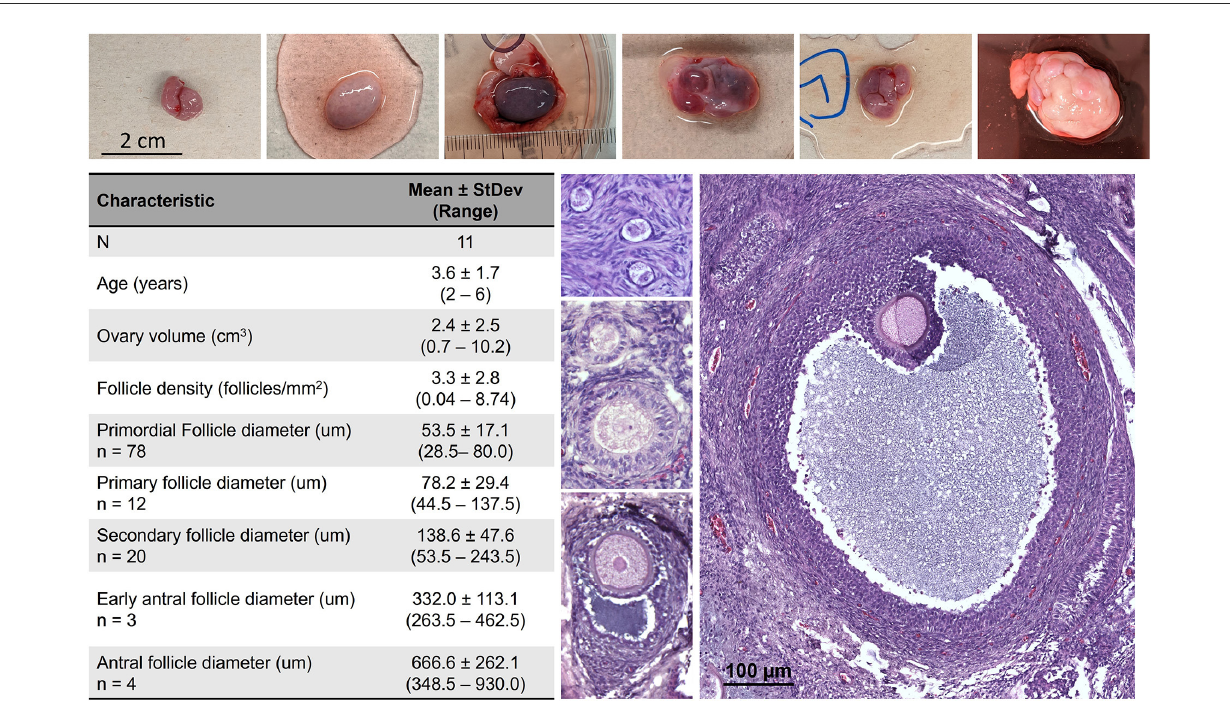
FIGURE2 African painted dog ( n = 11) ovarian tissue characteristics, with representative photos of ovaries and histological images of primordial, transitional, primary, secondary, early antral, and antral stage follicles. Antral stage follicles sizes reported were limited by the thickness of cortical tissue (1mm) preserved for